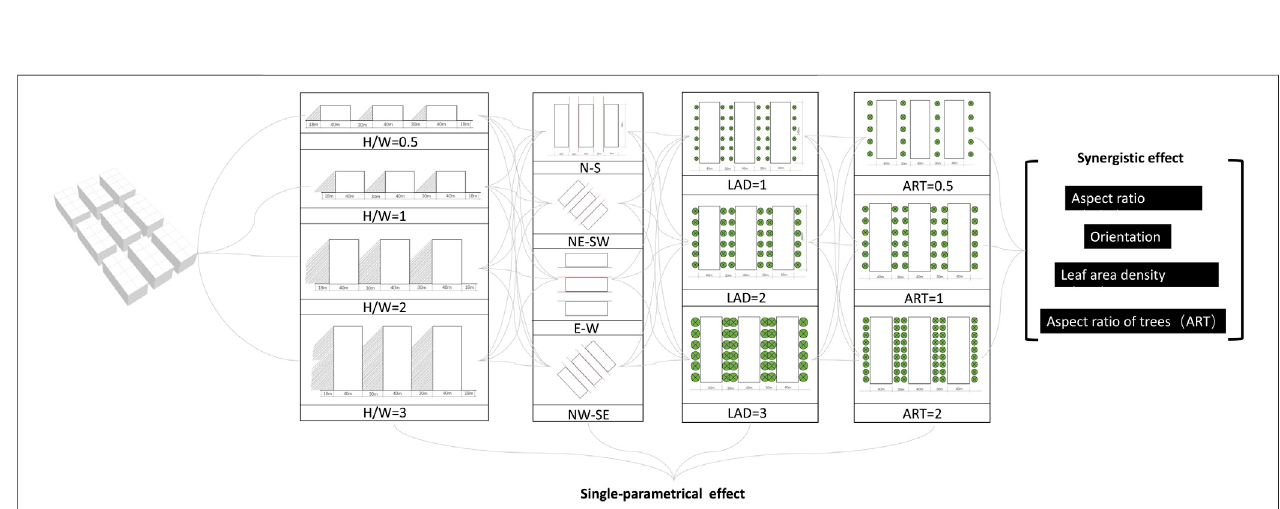
FIGURE 3 | Typological analysis of selected central business district Jiefangbei in Chongqing.